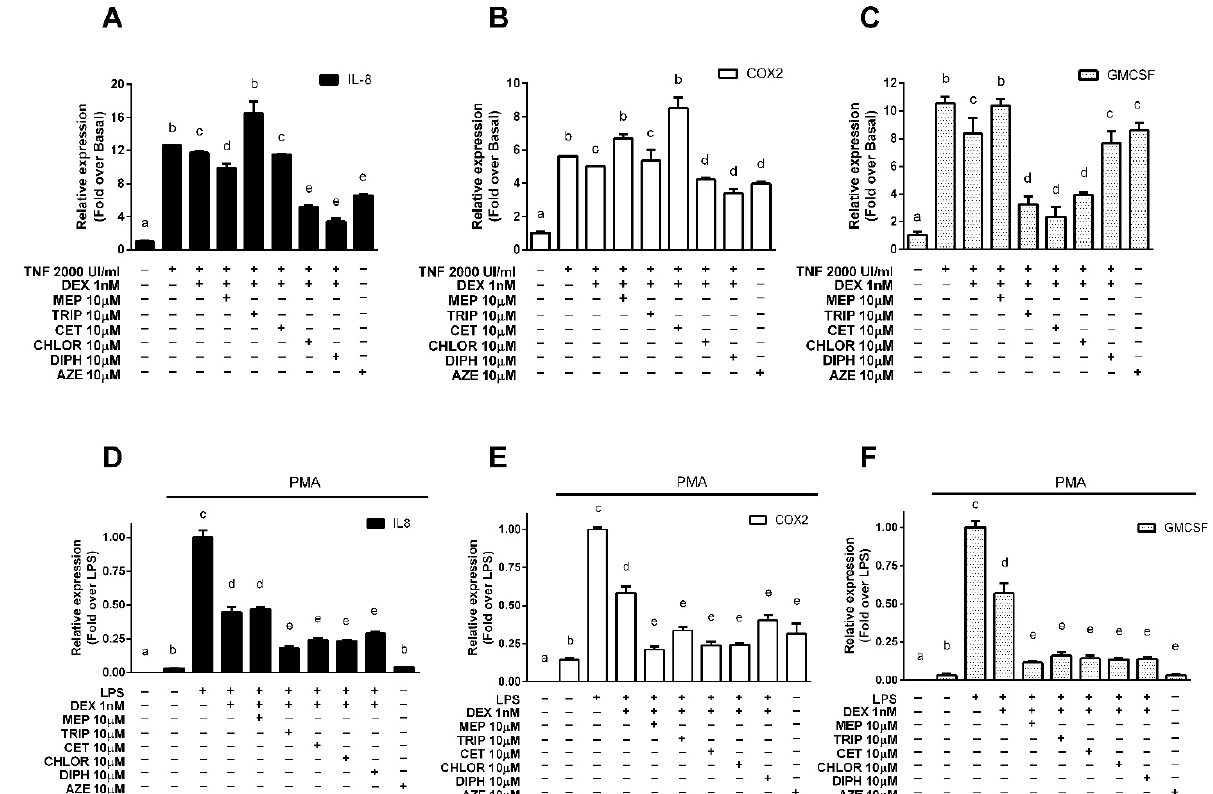
Figure 2. Antihistamines potentiate dexamethasone-induced transrepression of endogenous pro-inflammatory genes. ( A – C ) A549 cells were incubated with 2000 UI/mL TNF α for 4 h, exposed for 10 min to 10 µ M mepyramine (MEP), 10 µ M trans-triprolidine (TRIP), 10 µ M cetirizine (CET), 10 µ M chlorpheniramine (CHLOR), 10 µ M diphenhydramine (DIPH), or 10 µ M azelastine (AZE) as indicated, and then treated with 1 nM dexamethasone (DEX) for 3 h. ( D – F ) U937 cells were differentiated to macrophages with 100 nM PMA for 48 h and then stimulated with 1 µ g/ µ L LPS for 4 h. They were then treated for 10 min with 10 µ M mepyramine (MEP), 10 µ M trans-triprolidine (TRIP), 10 µ M cetirizine (CET), 10 µ M chlorpheniramine (CHLOR), 10 µ M diphenhydramine (DIPH), or 10 µ M azelastine (AZE) as indicated, and then exposed to 1 nM dexamethasone (DEX) for 3 h. IL-8, COX-2, and GMCSF mRNA levels were quantified by qPCR, as described in the methods section. Results are mean +/ − SD of at least three independent experiments performed in triplicates. Statistical significance was denoted using letters above bars. Means indicated with a common letter are not significantly different. Likewise, means not sharing any letter are significantly